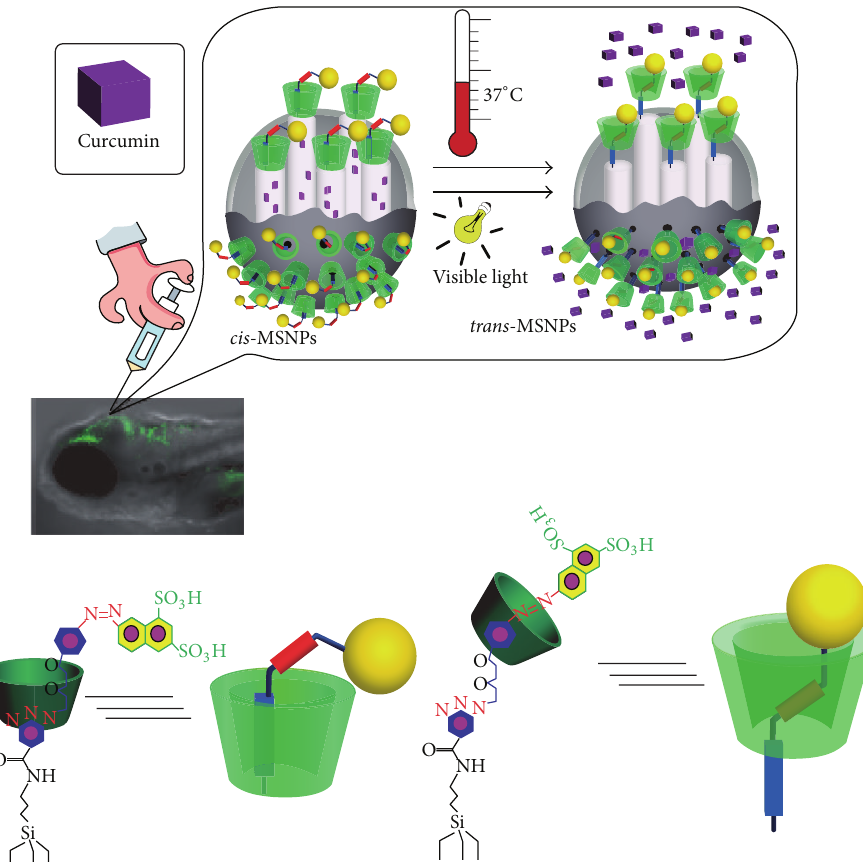
Figure 10: A graphical representation of the injection of drug-loaded MSNPs into zebrafish larvae for in vivo drug delivery triggered by either heating or visible light irradiation. MSNPs were functionalized with photothermal-responsive [2] rotaxanes on the surface. The chemical structure of the [2] rotaxane containing the 𝛼 -CD ring and azobenzene unit is shown (reproduced from [120], with permission from Wiley- VCH Verlag GmbH & Co. KGaA,